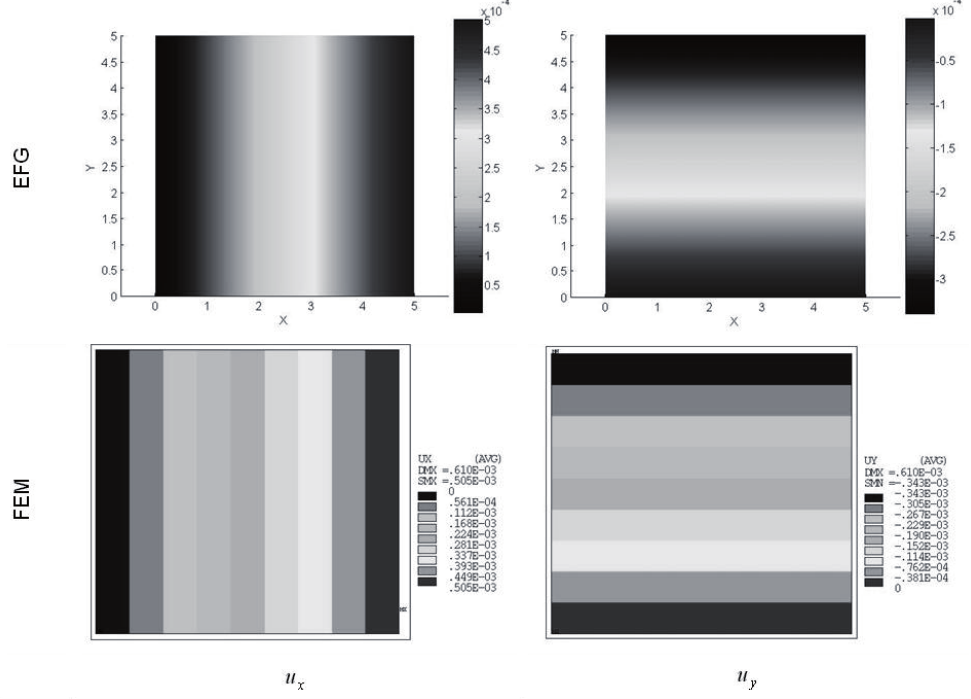
Fig. 4. M-H loop of the